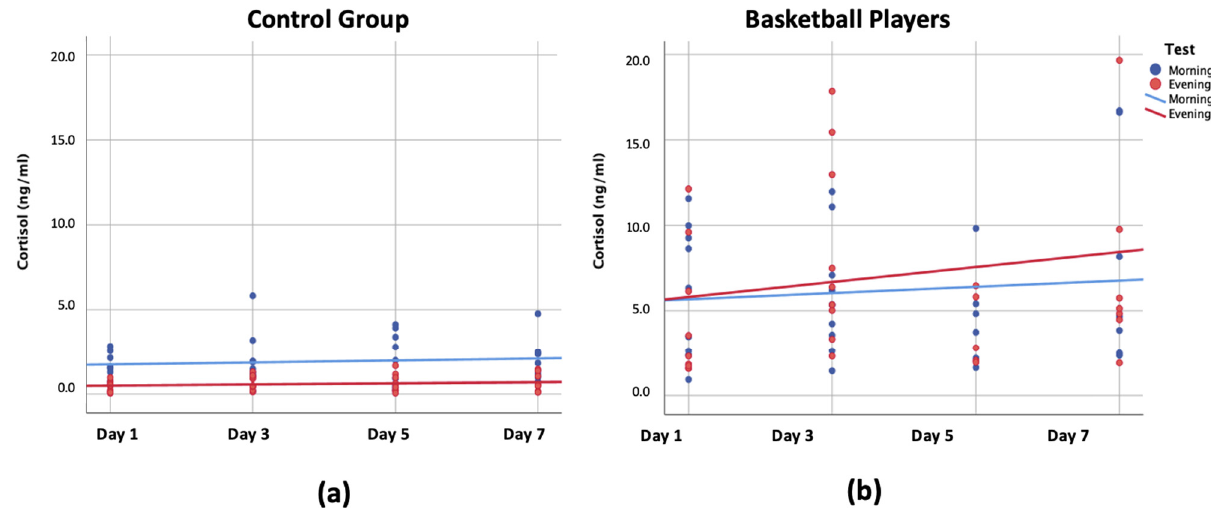
Figure 2. Dispersion of cortisol levels in control group ( a ) and basketball players ( b ), and on each of the days analyzed.